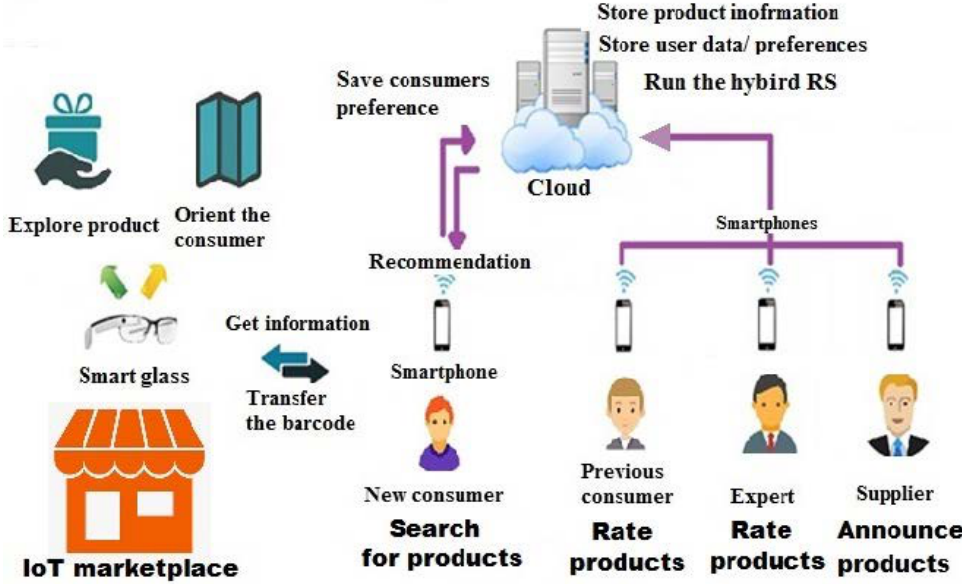
Figure 10. High-level system